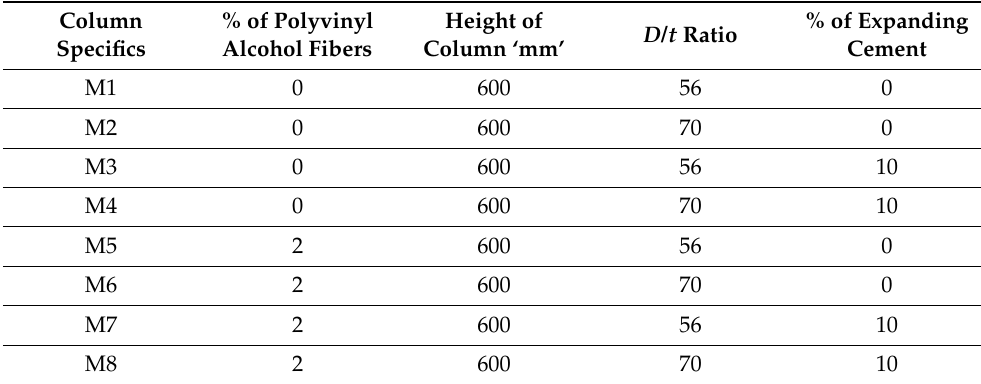
Table 3. The specifics of the fiber-reinforced self-stressed concrete columns.